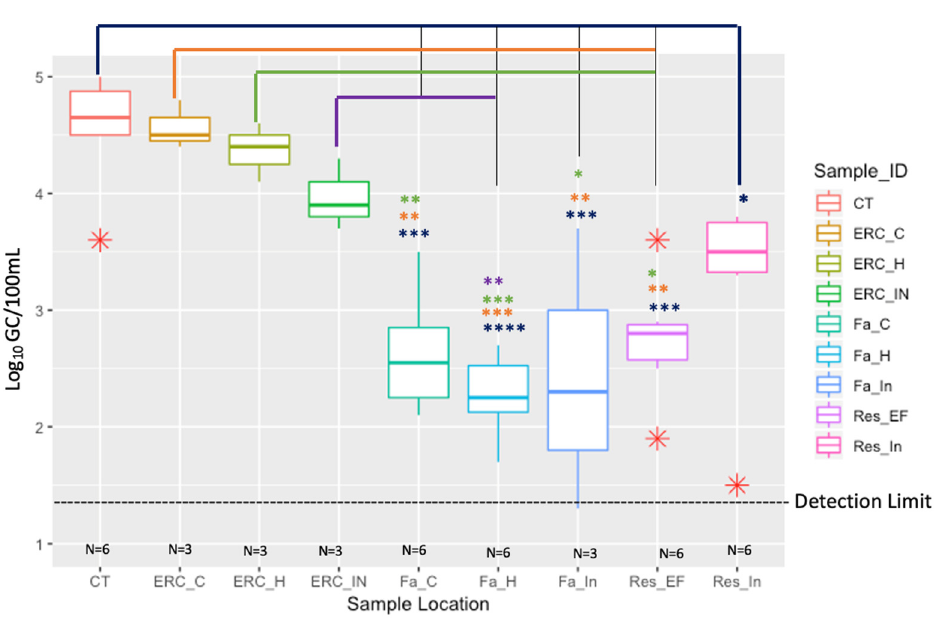
Figure 1. Comparison of Legionella spp. (23S rRNA) in the reservoir (RES_IN and RES_EF), buildings: Fa and ERC, and the Cooling Towers (CT). The water age (h) in Res_In (4.5 h), Res_EF (3.4 h), Fa (9.2 h), ERC (20.8 h), and CT (23.2 h). Description names are as follows: Res_In: Reservoir Influent; Res_Ef: Reservior Effluent; Fa_In: Fa Influent; Fa_H: Fa Hot-water tap; Fa_C: Fa Cold-water tap; ERC_In: ERC Influent; ERC_H: ERC Hot-water tap; ERC_C: ERC Cold-water tap; CT: Cooling Towers. The median of each measure is indicated by the thick colorful bar in each respective box; the first and third quartiles are represented by the bottom and top of the box, respectively; the red asterisks (*) show depicts the outliers within three sample types. The different asterisk (*, **, ***, ****) colors represent the significant difference between sampling location and is as follows: blue: CT; orange: ERC_C; green: ERC_H; purple: ERC_IN. Detection limit was 1.3 Log 10 GC/100 mL.